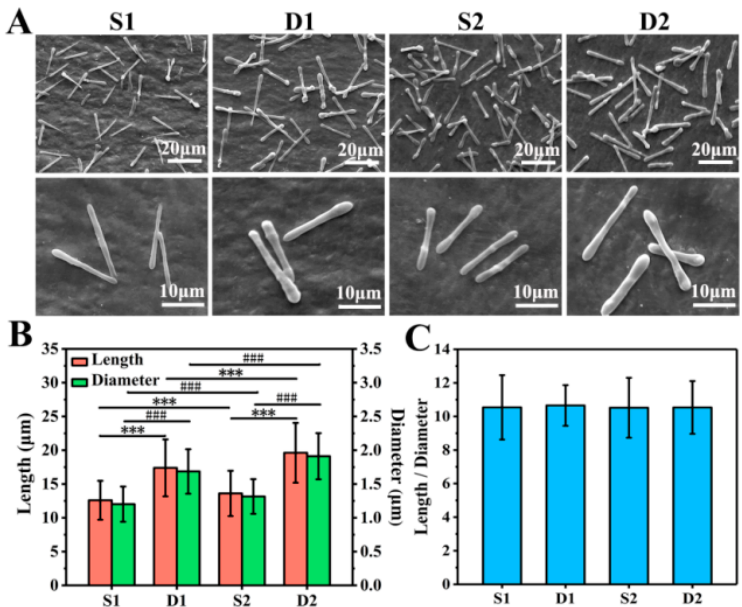
Figure 3. ( A ) SEM images of S1, D1, S2, and D2 DDCs. ( B ) Average lengths and diameters of S1, D1, S2, and D2 DDCs, showing a significant difference in length (*** p < 0.001) and in diameter ( ### p < 0.001). ( C ) Ratios of length to diameter of S1, D1, S2, and D2 DDCs; at least 400 of DDCs were observed to measure the length, diameter, and aspect ratio, using the software Image J 1.48v.